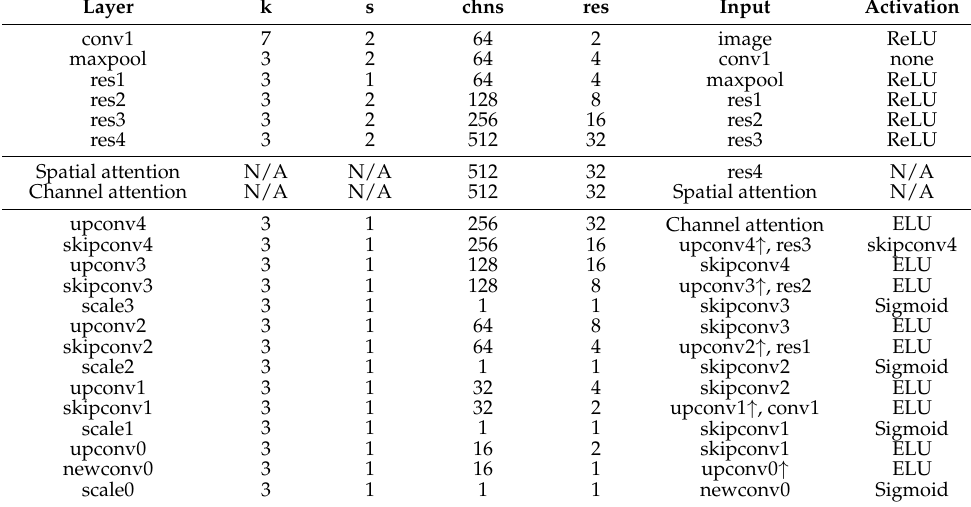
Table 1. Depth network. Here k is the kernel size and s is the stride. Chns denotes the number of output channels and res is the resolution scale, which represents the downscaling factor relative to the resolution of the input image. The symbol ↑ is a 2 × nearest-neighbor upsampling of the layer. The ‘none’ in the table means that there is no activation function in this layer.